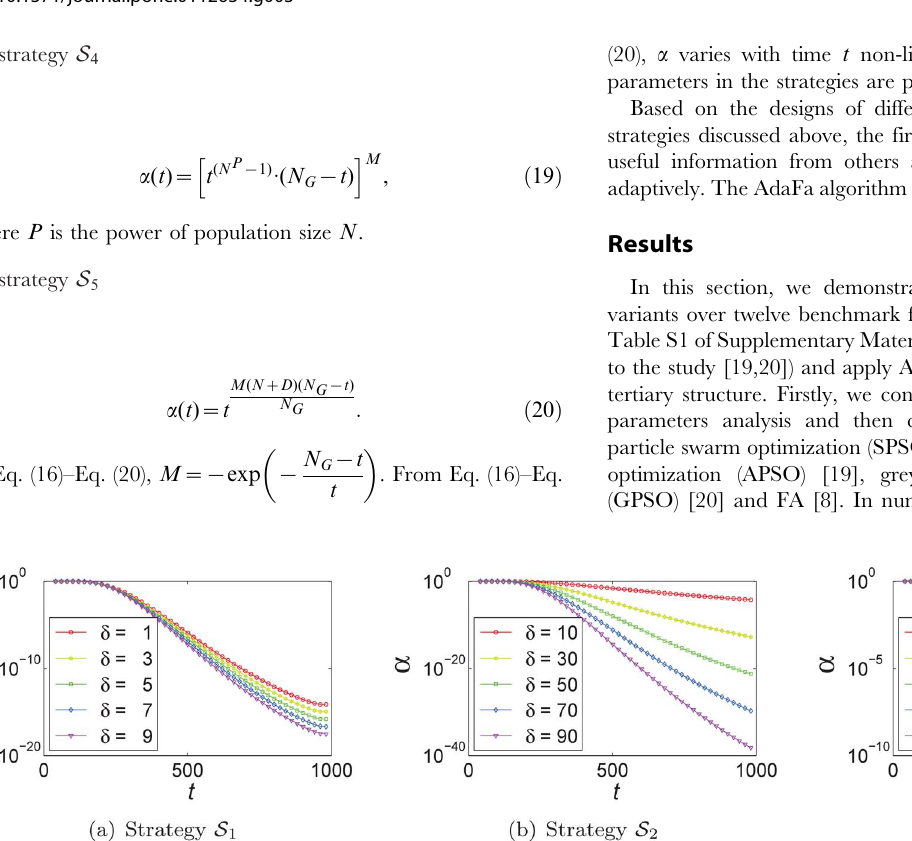
Figure 3. The relationship between g and performance of AdaFa.